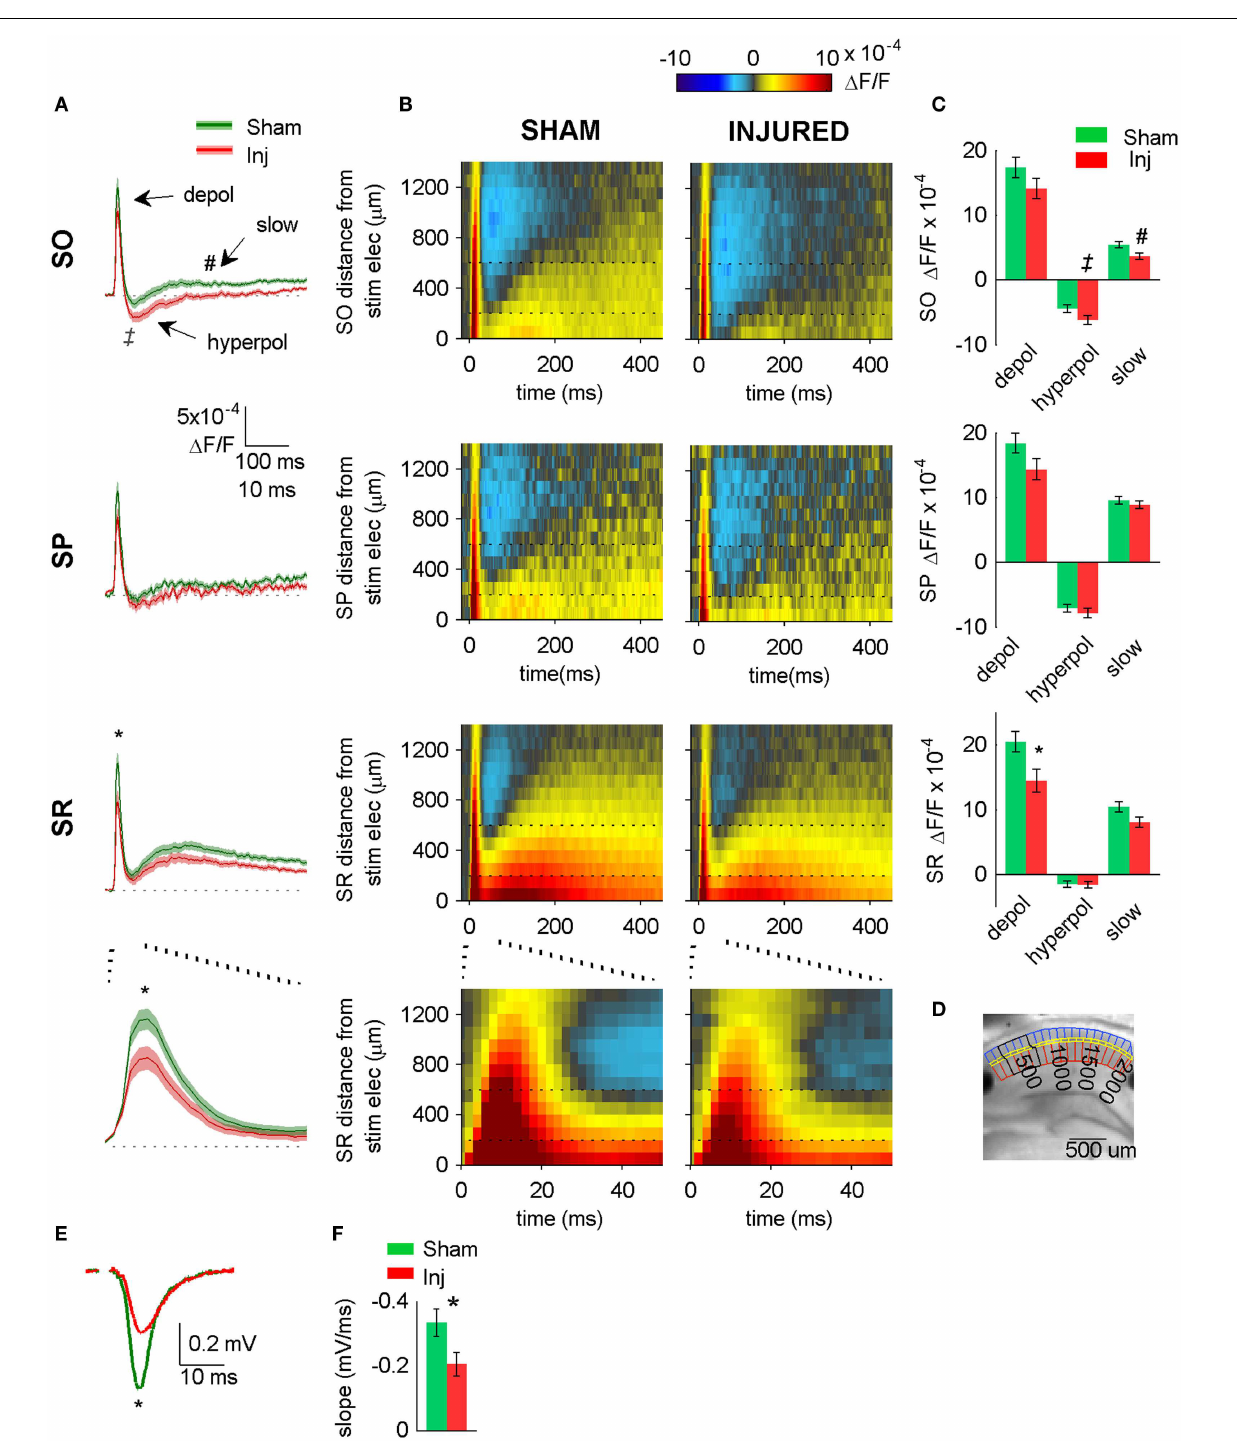
FIGURE 2 | Hyperpolarizing shift in SR-evoked responses after injury . (A) Group averageVSD signal shows decreased depolarization in SR (lower two panels), increased hyperpolarization in SO (upper panel) after injury. Average traces for sham ( n = 25) and injured ( n = 22) calculated from region indicated in (D) below. Shaded region for each plot in this and subsequent figures indicates mean ± SE. Bottom panel shows lower middle panel on